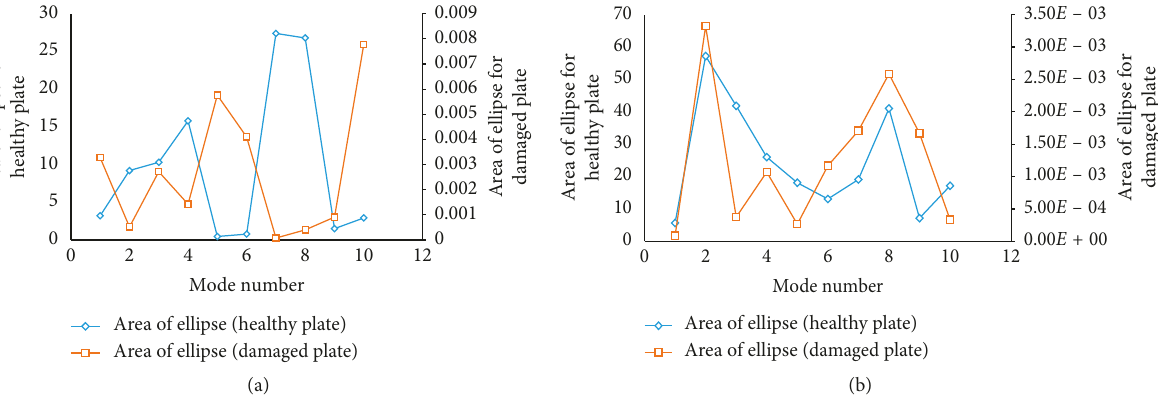
plate)Area of ellipse (healthy plate) Area of ellipse (damaged Figure 6: Variation in the area of the ellipse for plates (a) D1 and (b) E1.